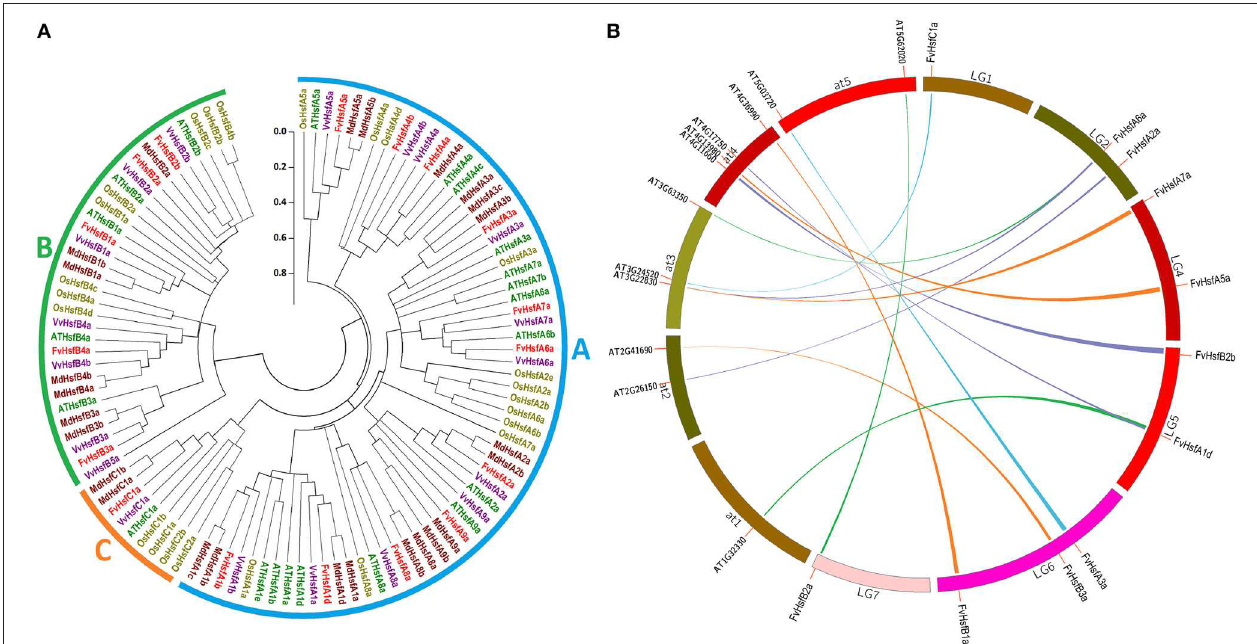
FIGURE 1 | Comparative analysis of strawberry Hsf genes with the corresponding genes in rice, apple, grapevine, and Arabidopsis . (A) The linearized neighbor-joining phylogenetic tree of Hsf proteins from strawberry, rice, apple, grapevine, and Arabidopsis . The full-length amino acid sequences of the Hsf proteins were used to construct the phylogenetic tree using the MEGA 5.0 program. Unrooted neighbor-joining analysis was performed with pairwise deletion and the Jones-Taylor-Thornton (JTT) model. The filled circle lines were used to cluster the genes into the A, B, and C classes. (B) Synteny analysis of strawberry and Arabidopsis Hsf genes. The strawberry and Arabidopsis chromosomes are depicted as a circle. The approximate location of each AtHsf and FvHsf gene is marked with a short red line on the circle. The colored curves denote the syntenic regions of the strawberry and Arabidopsis Hsf